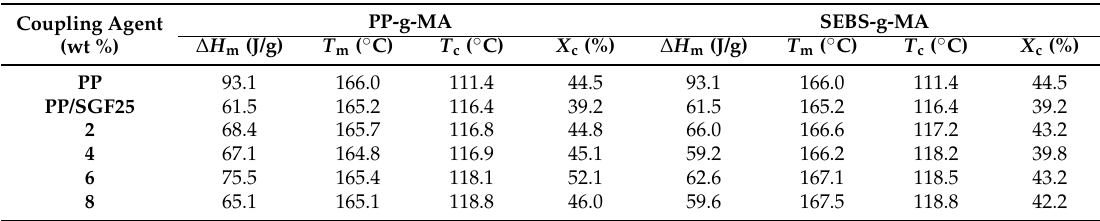
Figure 10. SEM images (800×) of PP/SGF composites, which are incorporated with ( a ) 0 wt % of a coupling agent; ( b ) 2 wt %; ( c ) 4 wt %; ( d ) 6 wt %; and ( e ) 8 wt % of PP-g-MA; as well as ( f ) 2 wt %; ( g ) 4 wt %; ( h ) 6 wt %; and ( i ) 8 wt % of SEBS-g-MA.